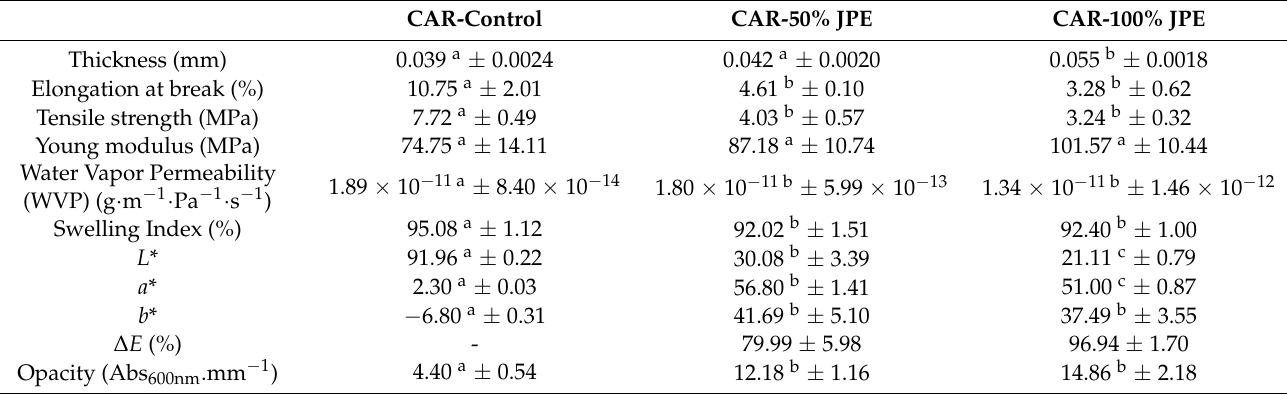
Table 2. Biodegradable films characterization.